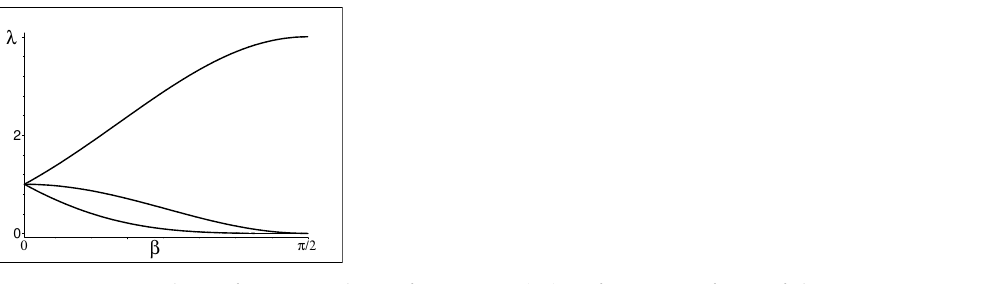
Figure 3. Eigenvalues of our singularity-free metric (17) as functions of one of the parameters at N =